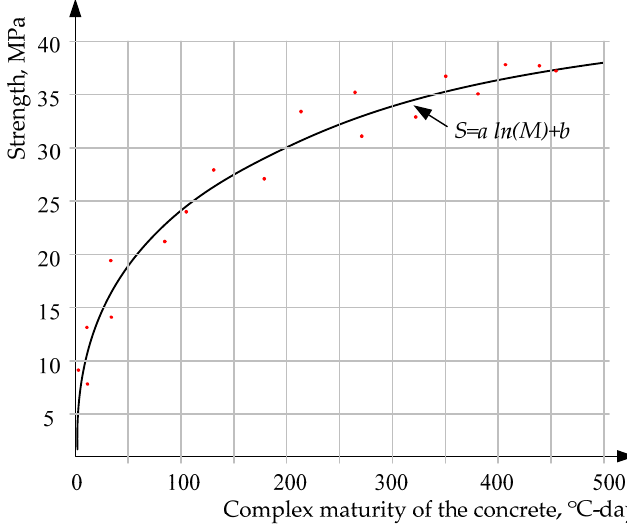
Figure 3. Relationship between complex maturity and strength of the concrete.